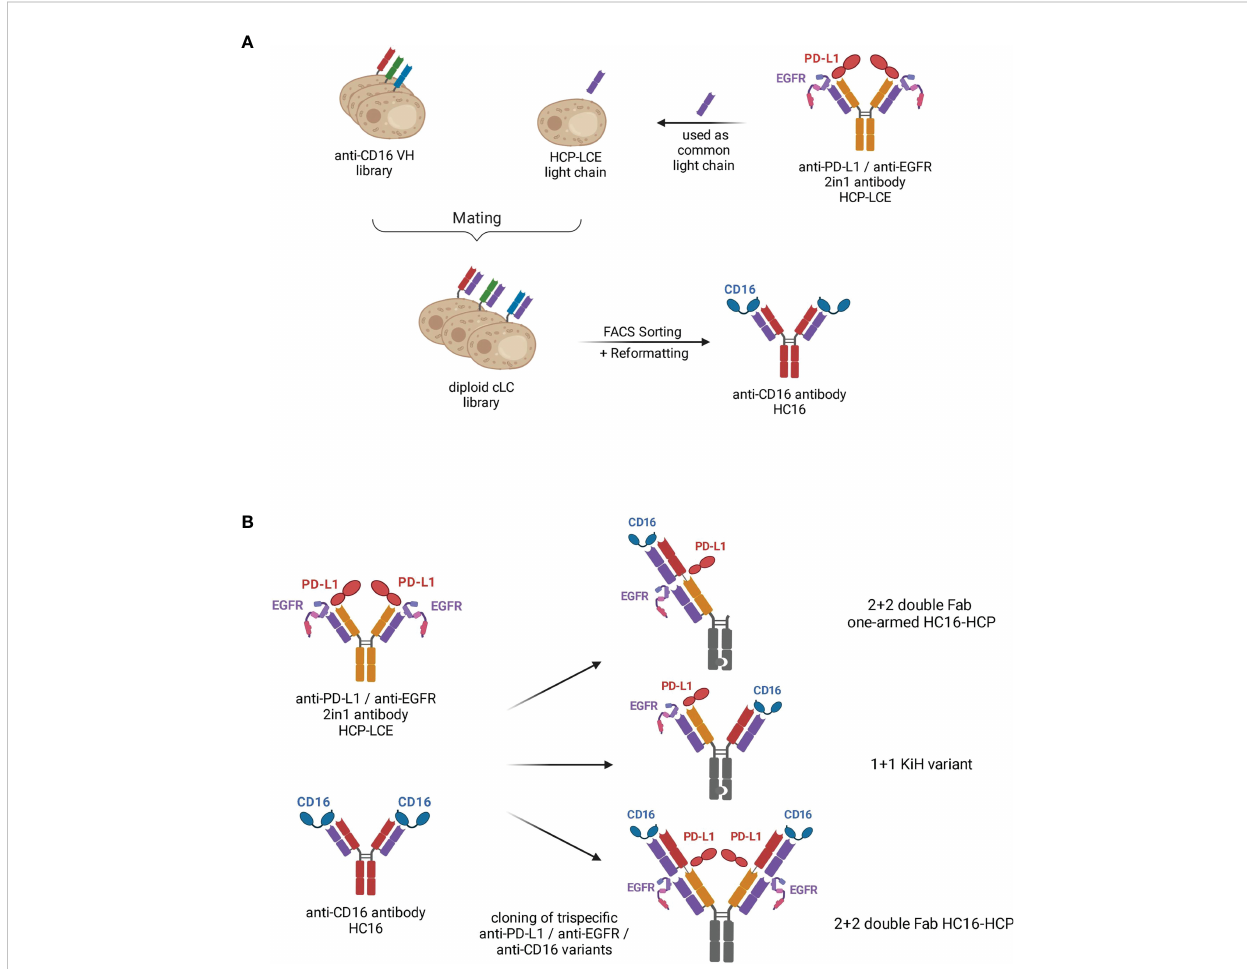
FIGURE 1 Schematic representation demonstrating the generation of trispeci fi c antibody variants based on the two-in-one antibody HCP-LCE. (A) The VL fragment of the anti-PD-L1/anti-EGFR two-in-one antibody HCP-LCE was paired with an anti-CD16a VH yeast surface display library by yeast mating. FACS screening and subsequent reformatting into full-length antibody format enabled the isolation of the anti-CD16 antibody HC16. (B) Based on the antibodies HCP-LCE and HC16, three different trispeci fi c anti-PD-L1/anti-EGFR/anti-CD16 antibody variants were generated. Created with